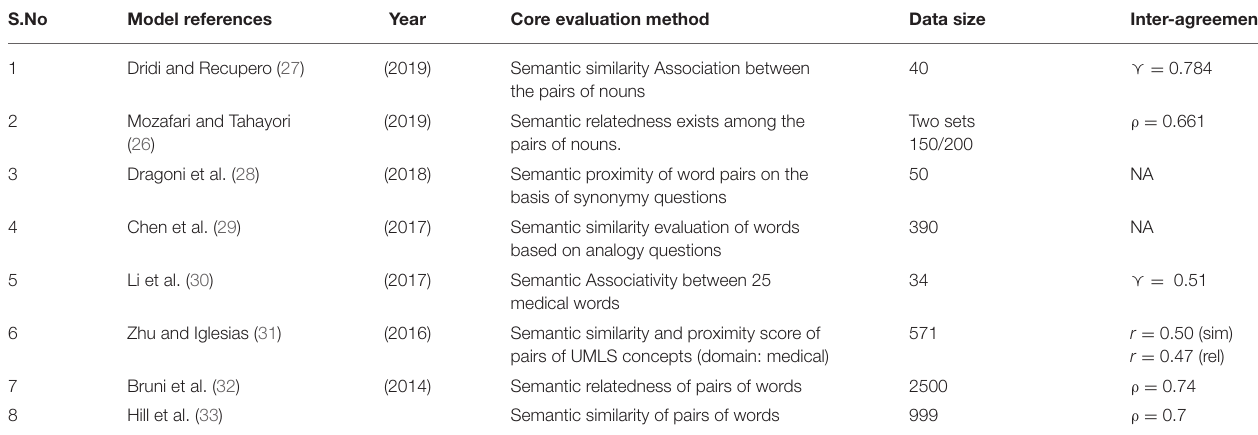
TABLE 1 | Highlights of semantic similarity measures and dataset